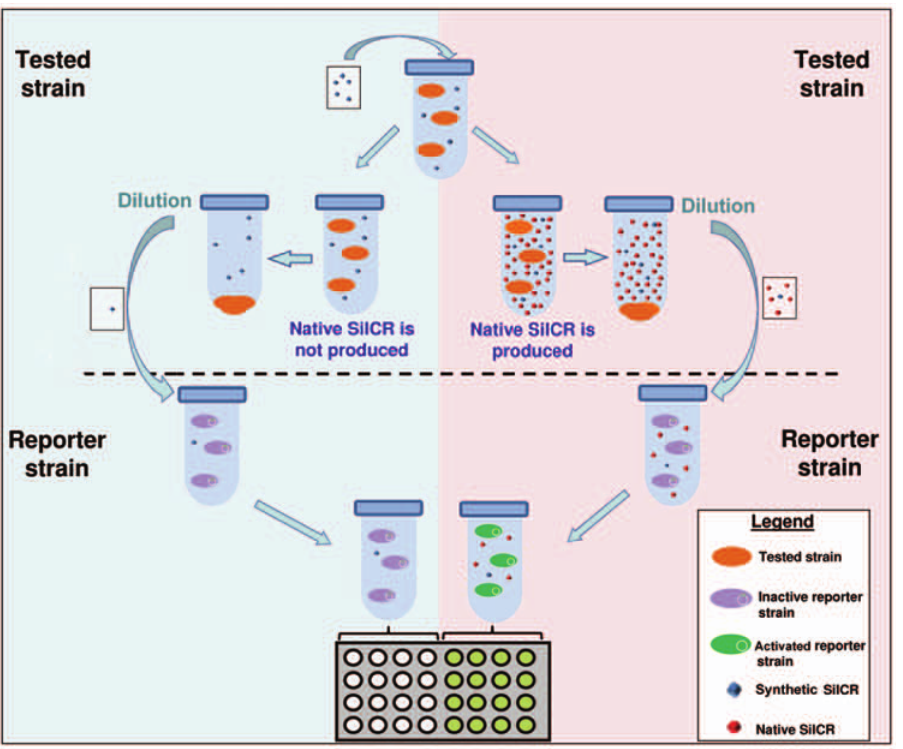
Figure 6. ‘‘Jump start’’ experiment scheme. The tested strain is grown in the presence of 5 ng ml 2 1 of synthetic SilCR to late log phase (OD 600 =1). Then, the supernatant of the tested culture is collected, diluted 10 or 3-fold and added to the ‘‘reporter strain’’ JS95 or N9 (respectively), harboring p P 4 -gfp . After incubation for 2 additional hours at 37 u C, the relative fluorescence of the ‘‘reporter strain’’ is determined as described in Figure